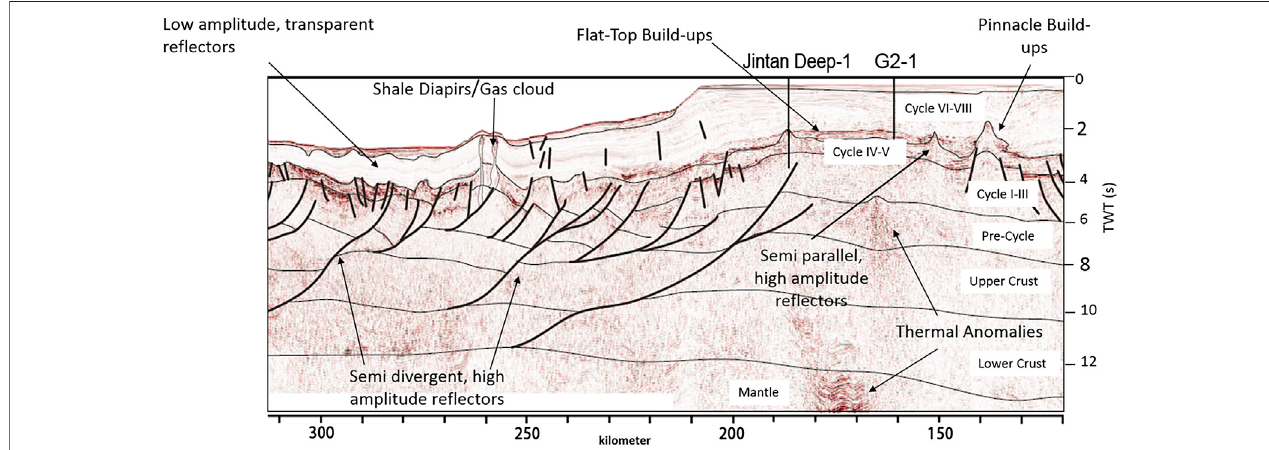
FIGURE6| Zoominsectionfrom Figure4 tohighlightthegeologicalfeaturesinterpretedincludingtheshalediapirs,seismicfaciesandcharacteristicsoflimestone build-ups in Luconia.